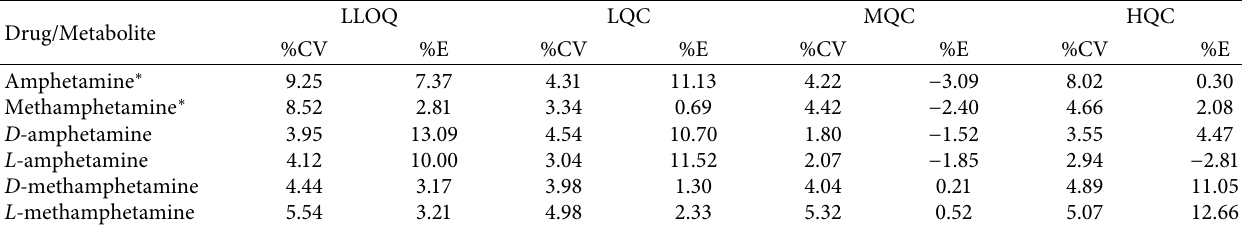
Table 5: Interassay precision and accuracy: precision and accuracy over 3 days with replicates of 6 for a total of 18 samples.